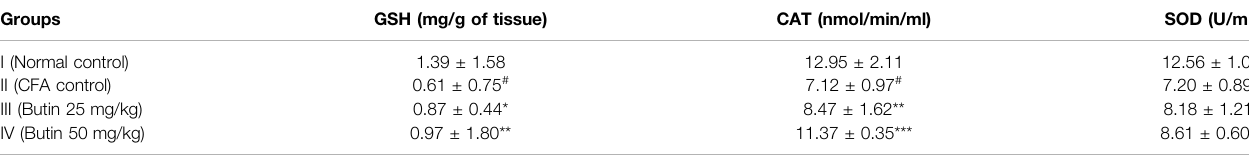
TABLE 2 | Effect of butin on endogenous antioxidant levels (GSH, CAT, and SOD) in experimental rats.